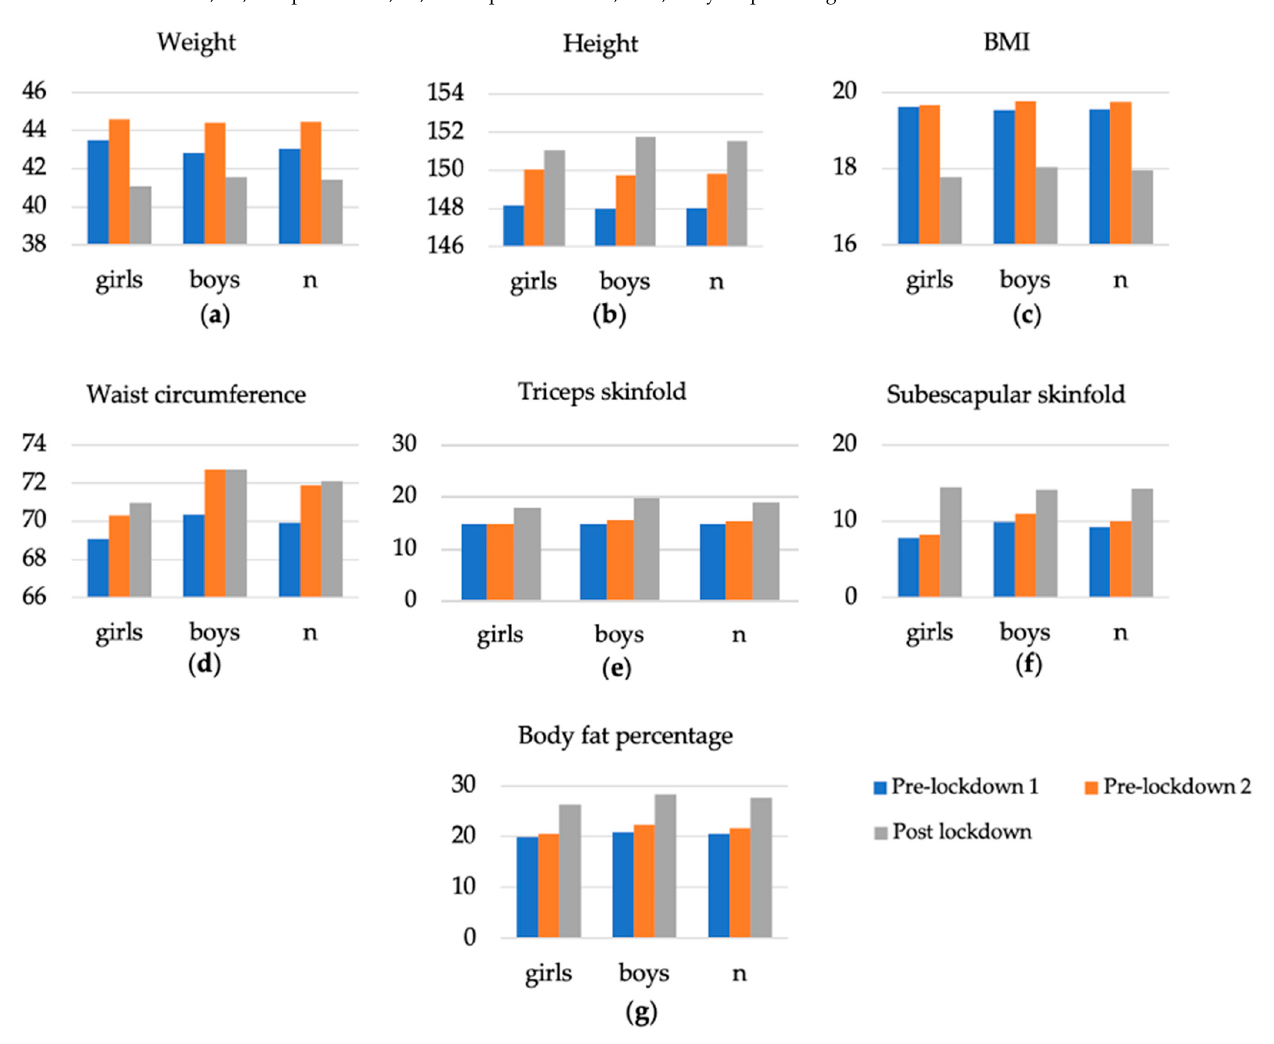
Figure 2. Changes in anthropometric variables in the sample and between genders. ( a ) Changes in the anthropometric variable of weight. ( b ) Changes in the anthropometric variable for height. ( c ) Changes in the anthropometric variable of BMI. ( d ) Changes in the anthropometric variable for waist circumference. ( e ) Trend of the anthropometric variable of triceps skinfold. ( f ) Evolution of the anthropometric variable of the subscapular skinfold. ( g ) Evolution of the anthropometric variable of the body fat percentage.